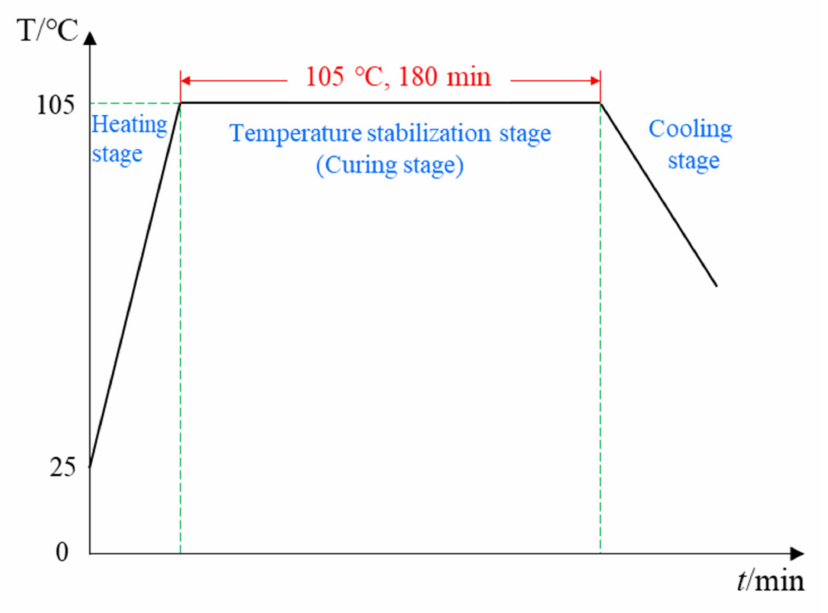
Figure 4. Recommended heating profile of the T300 prepreg provided by the